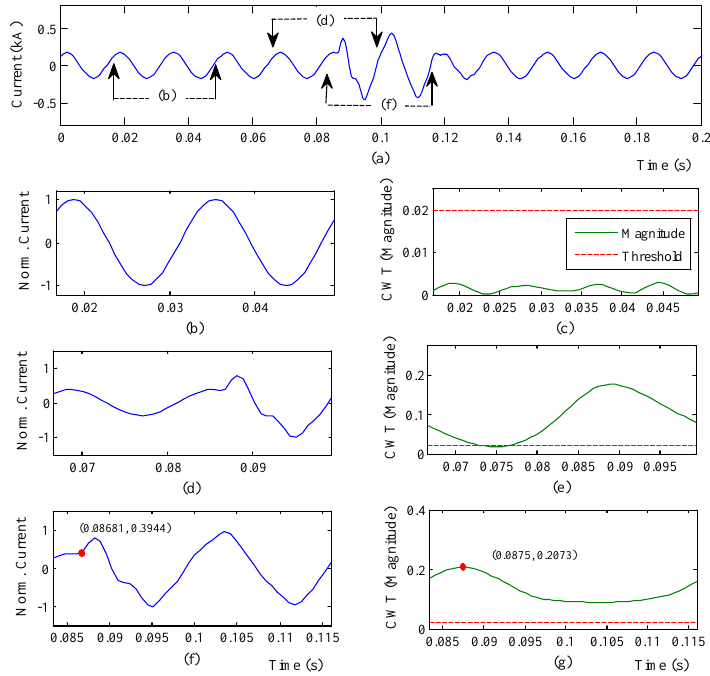
Figure 5. Flowchart of detection process. FFT: fast Fourier transform; CWT: continuous wavelet transform; DT: decision tree.